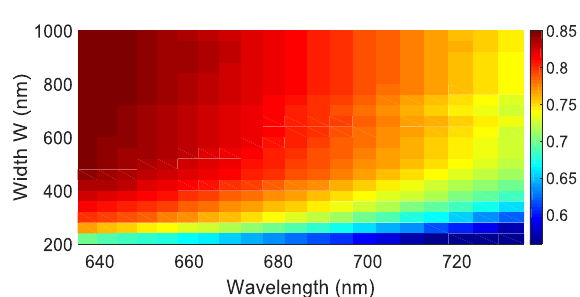
Fig. 4. The fraction of absorbed power by the Si rib waveguide of length 10µm with width W when light is end-fire coupled from the SiN waveguide with width